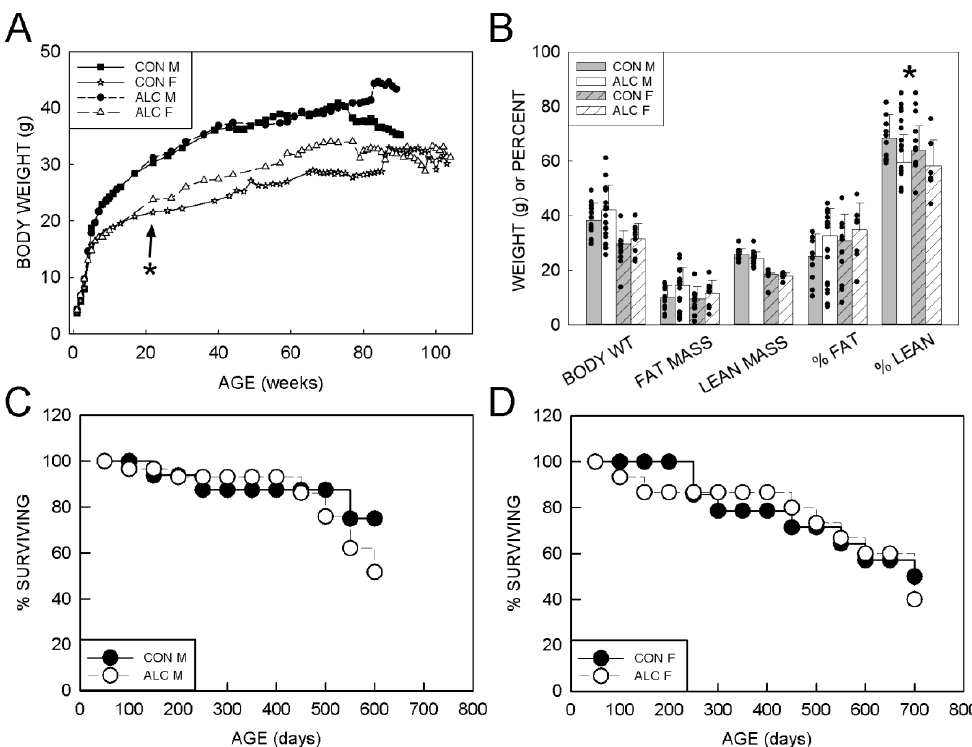
Figure 1. Body weights, body composition, and survival of ALC and CON mice. ( A ) Body weights of males (closed symbols) and females (open symbols). ALC females are heavier ( p < 0.001) than CON from 200 days onward (arrow). ( B ) Body composition for 18-month-old CON and ALC mice; lean mass and fat mass are presented as both absolute weights (g) and as a percentage of body weight. ( C ) Percent survival of male ALC and CON mice. ( D ) Percent survival of female ALC and CON mice. N = 10 – 12 F and 16 – 22 M per group. * Indicates ALC differs from CON at p ≤ 0.05. ALC – alcohol-exposed. CON – control. F – female. M – male.